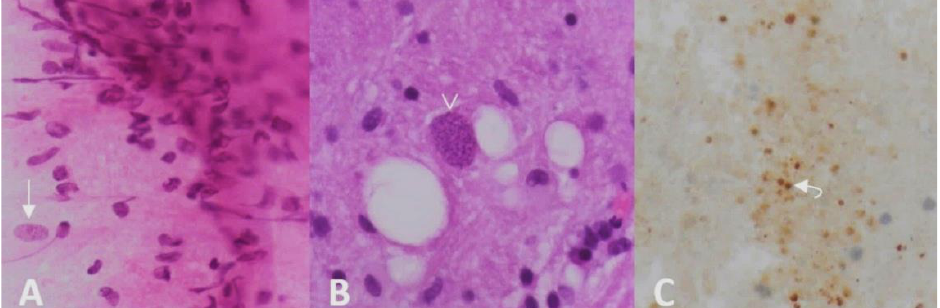
Figure 3. Brain intraoperative smear ( A ) showed cysts with bradyzoites ( arrow ) in a background of glial tissue. Definitive histopathological exam ( B ) confirmed the presence of bradyzoite cysts ( arrowhead ) and chronic inflammatory cells. Immunohistochemical stain ( C ) with anti-Toxoplasma antibody highlighted the more elusive free tachyzoites ( curved arrow ).